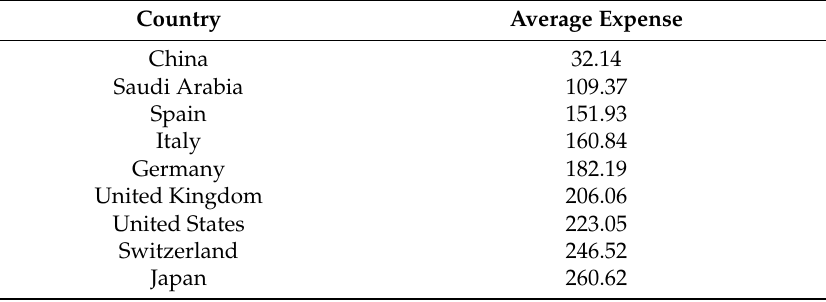
Table 2. Cosmetics spending 2